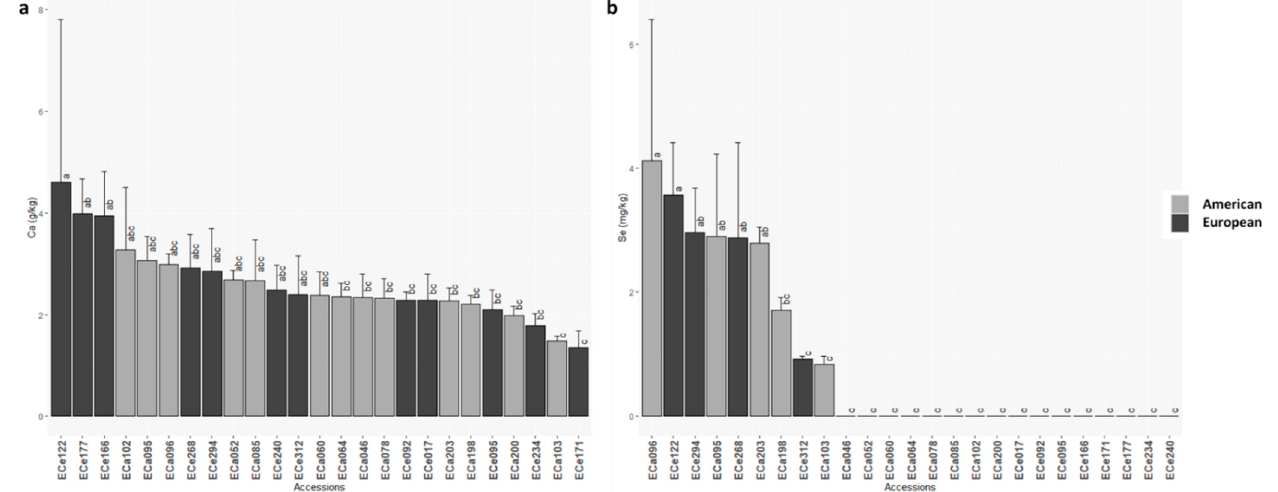
Figure 4. Mean Ca ( a ) and Sel ( b ) contents for the 25 American and European accessions. Columns with different letters are significantly different ( p < 0.05; Tukey tests).